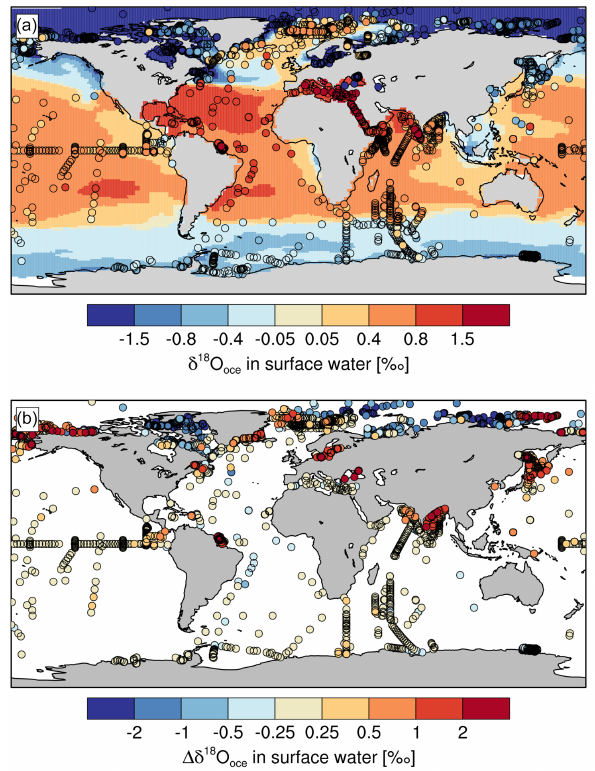
Figure 2. (a) Global distribution of simulated and observed an- nual mean δ 18 O oce values in ocean surface waters (mean over the depth interval between surface and 10m). The background pattern shows the δ 18 O oce distribution as simulated by the ECHAM5/MPI- OM model set-up. Data entries from the GISS database are plotted as coloured symbols. (b) Anomaly plot for the difference of the mean modelled vs. observational values ( (cid:49)δ 18 O oce = δ 18 O oce − δ 18 O GISS ) at the positions of the GISS data entries. For the cal- culation of (cid:49)δ 18 O oce , the month of sampling has been considered (see text for details).